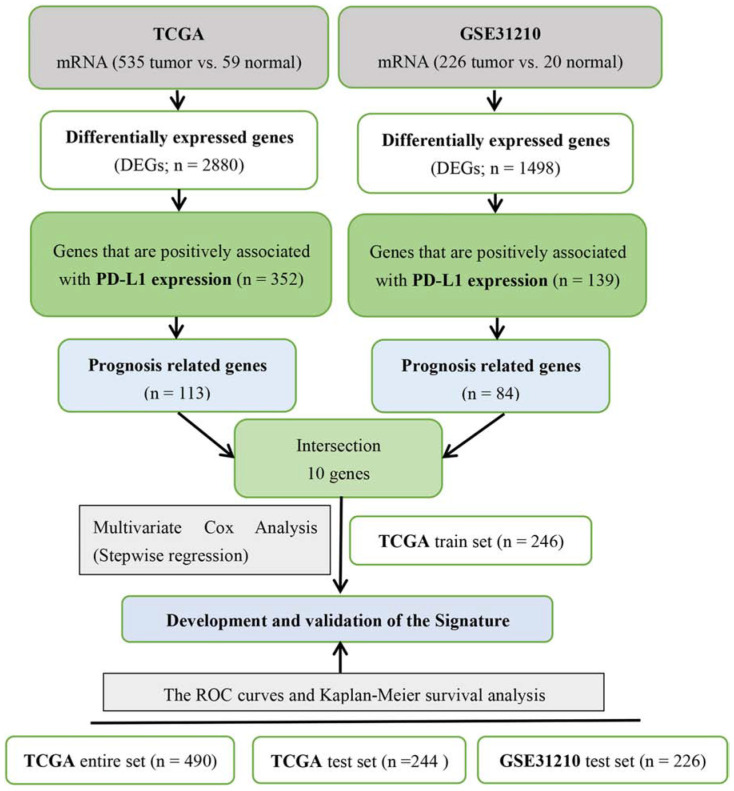
Detailed process of the combined two-mRNA signature construction.